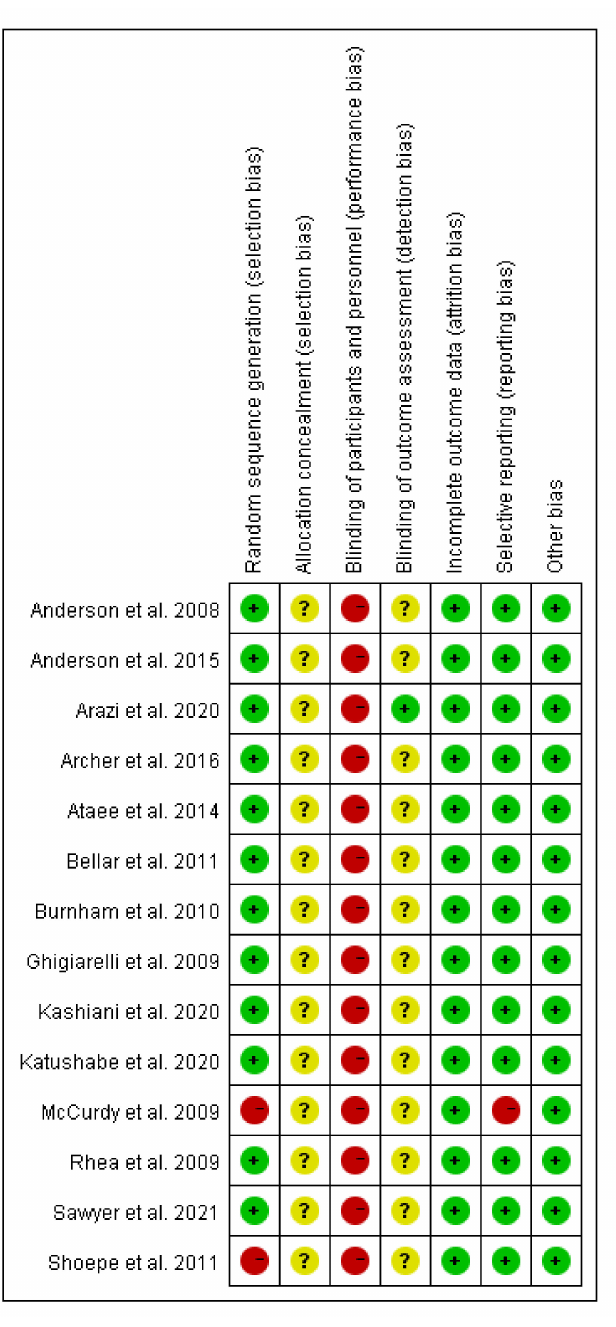
Figure 5. Summary of the risk of bias of studies included in this meta-analysis. Green indicates a low risk of bias, yellow indicates unclear bias, and red indicates a high bias